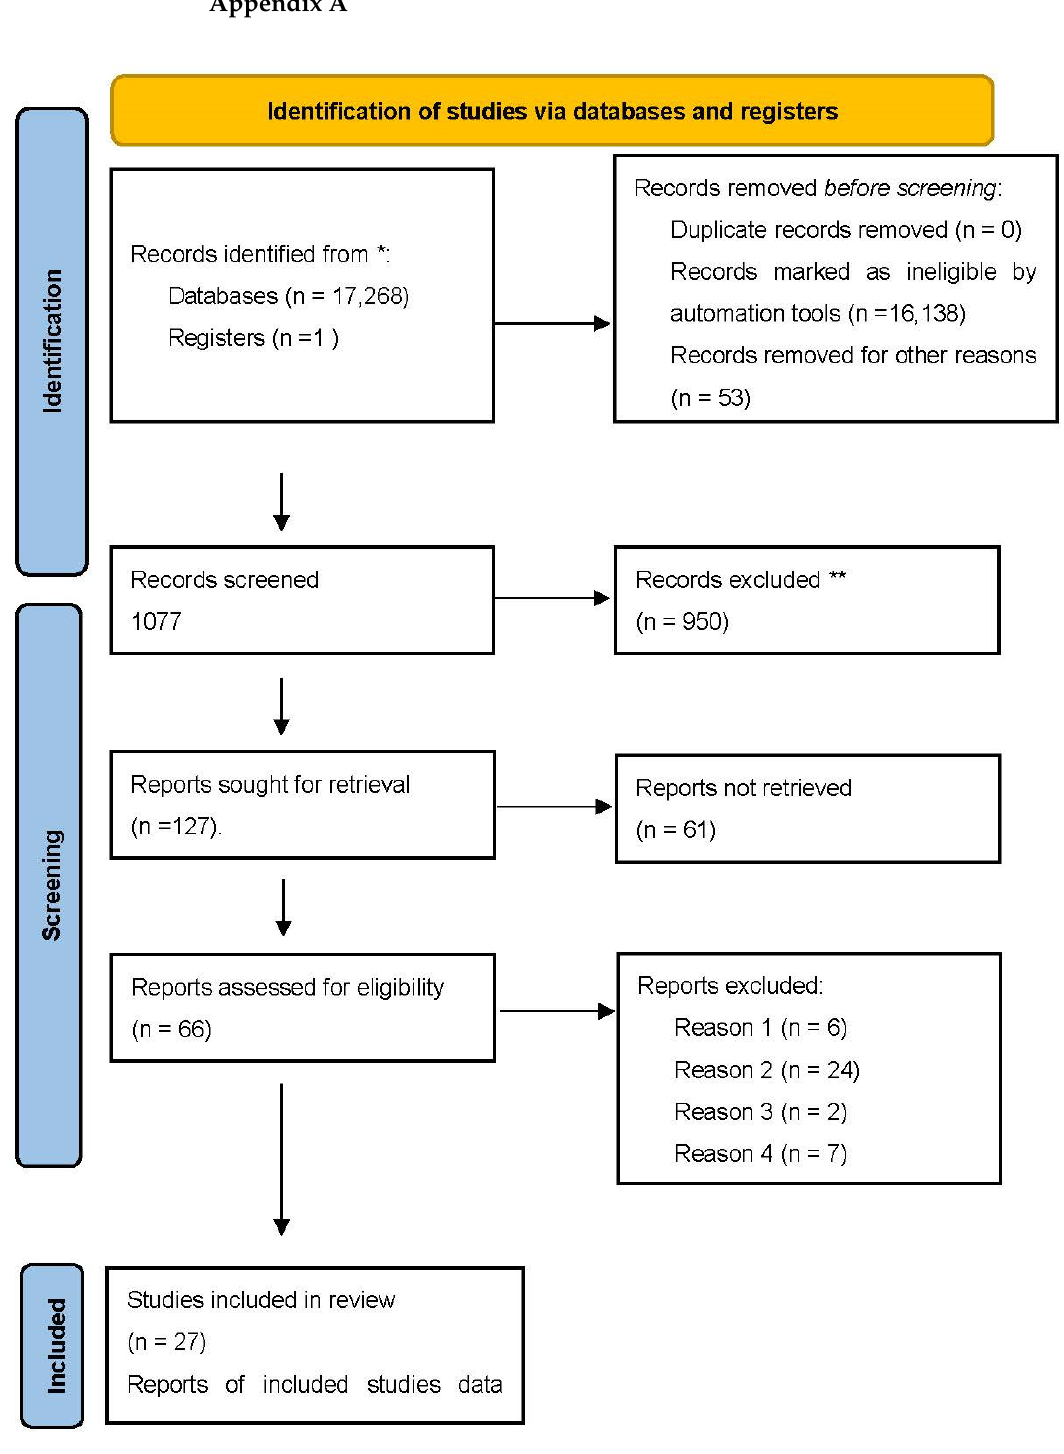
Figure A1. PRISMA Flow Diagram of Literature identification and selection. Literature identified * (database 17268, register 1), Records excluded ** 950. The final records from data bases 27 and 1 register.